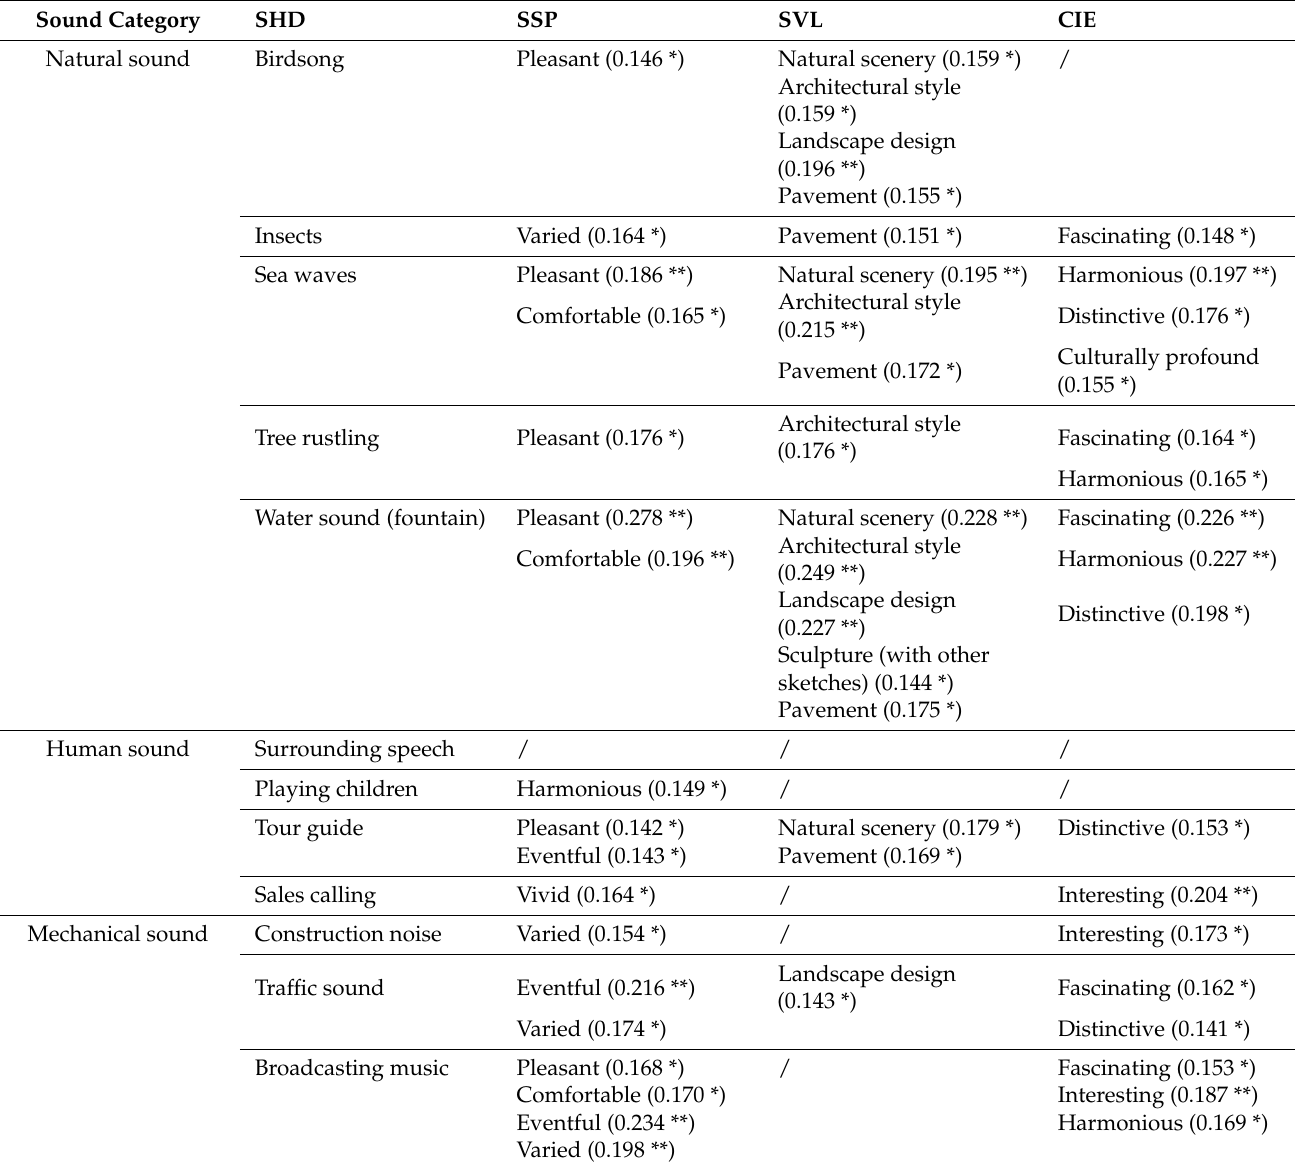
Table 3. The correlation coefficients between the SHD of each of the sound sources and the visiting experience indicators, SSP: soundscape perception, SVL: satisfaction degree of visual landscape, CIE: comprehensive